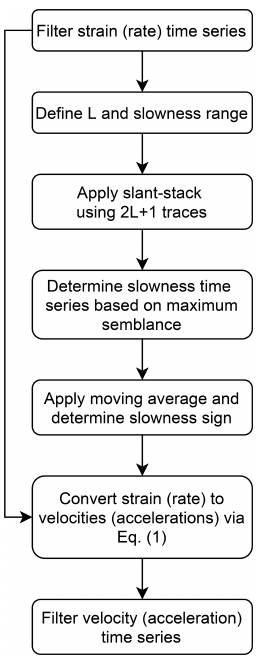
Figure 1. Flow chart detailing the conversion procedure from DAS strain (rate) signals to ground velocity